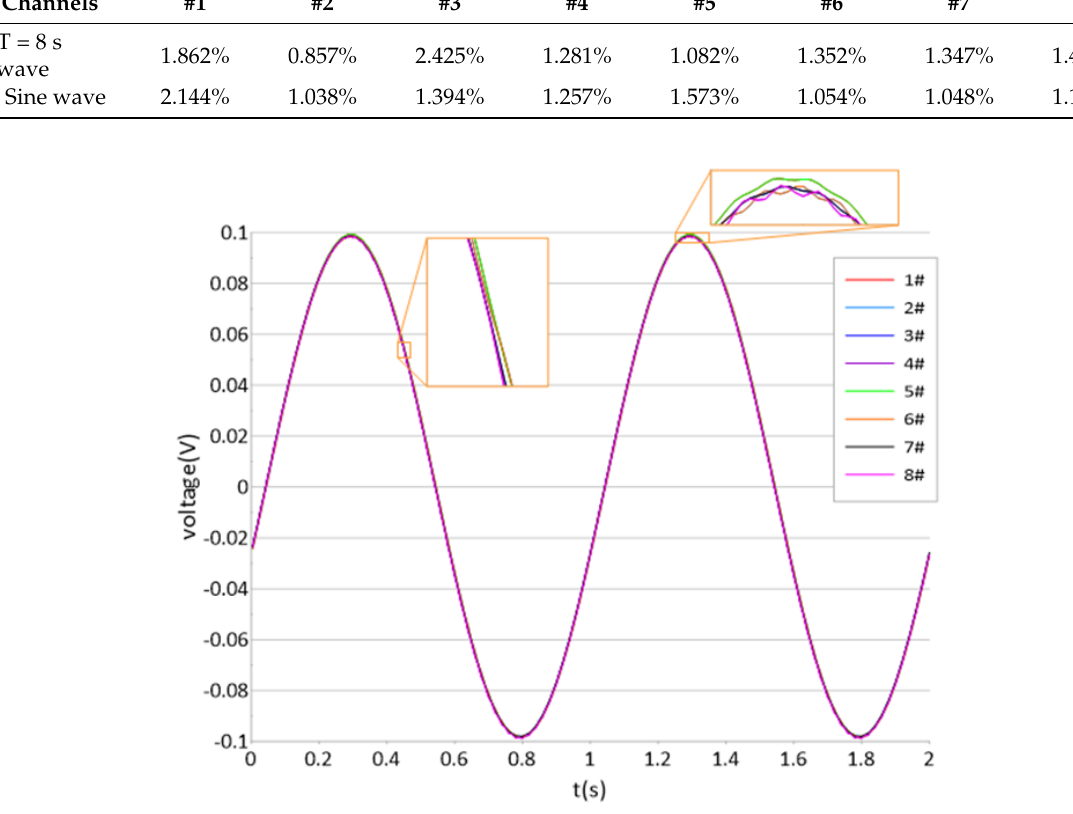
Figure 18. Sampled waveform for each channel for the Sine wave.